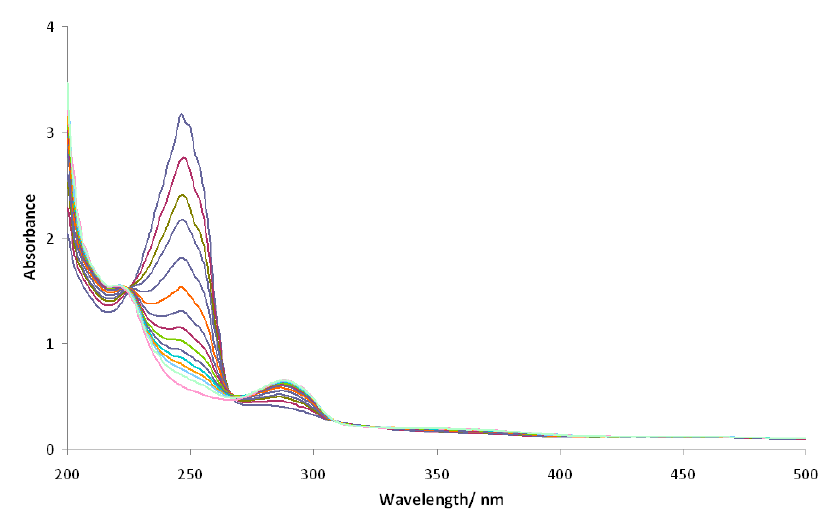
Figure 7. Ultraviolet spectra variation for p-benzoquinone during the water photolysis experiments using biocatalyst 1 , showing the decrease in the 246 nm band (disappearance of benzoquinone) and increase in the 290 nm band (formation of hydroquinone). Grey color corresponds to spectrum at time zero, and pink color corresponds to spectrum at 24 h.